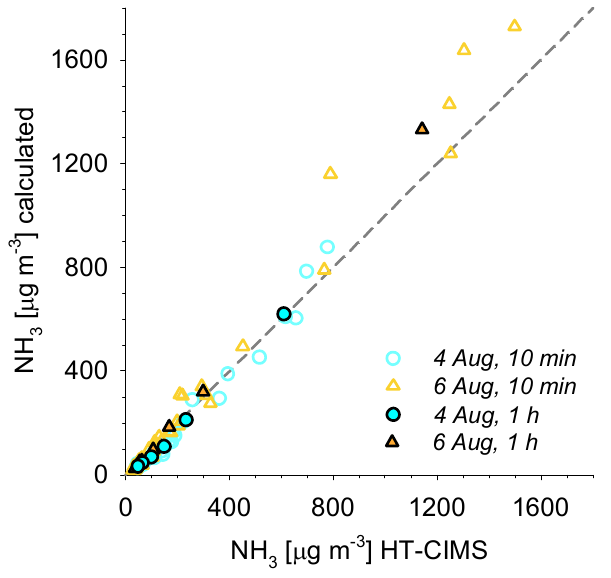
Fig. 10. Measured HT-CIMS NH 3 concentrations (averaged over 10min and 1h) vs. corresponding concentrations calculated by bLS using F volat , EC ; dashed line shows 1:1